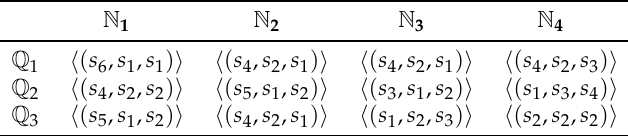
Table 5. The linguistic picture fuzzy decision